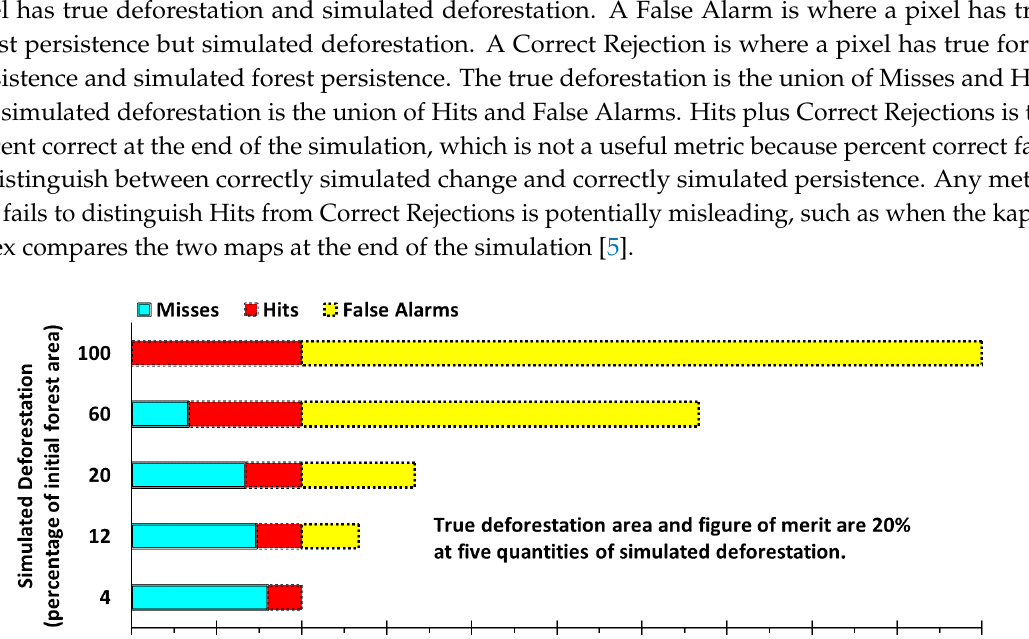
Figure of Merit = (True ∩ Simulated)/(True ∪ Simulated)